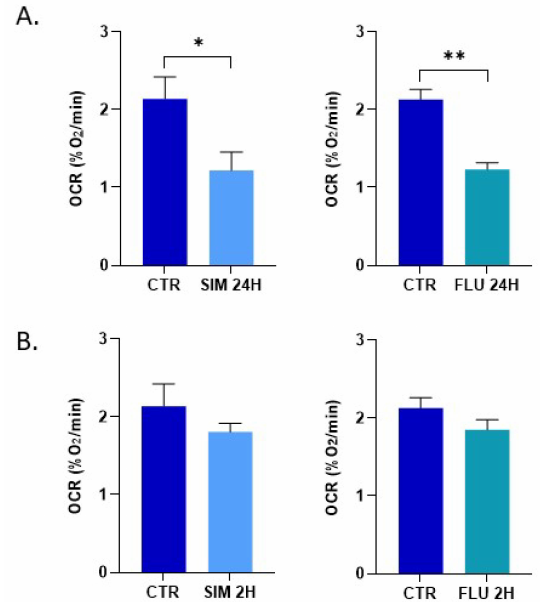
Figure 3. Impact of statins on the oxygen consumption rate (OCR) by prostate cancer cells as measured by EPR respirometry. ( A ) effect of a 24 h exposure to simvastatin and fluvastatin (10 µ M) on the OCR of PC-3 cells; ( B ) effect of a 2 h exposure to simvastatin and fluvastatin (10 µ M) on the OCR of PC-3 cells. Bars represent means ± SEM (% O 2 /min), (*) p < 0.05, (**) p < 0.01, Student’s t -test, n =